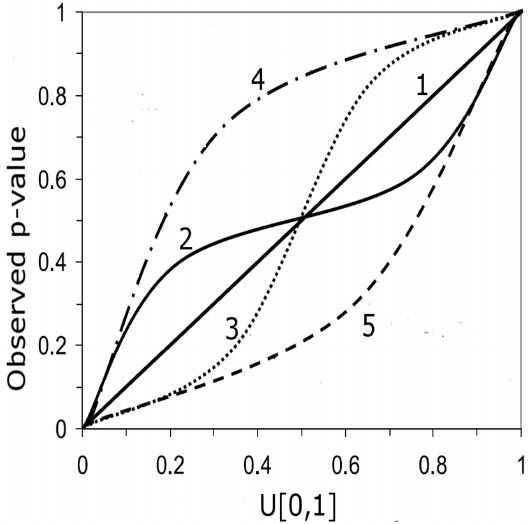
Figure 5. Interpretation of the predictive qq (pqq)-plot adapted from